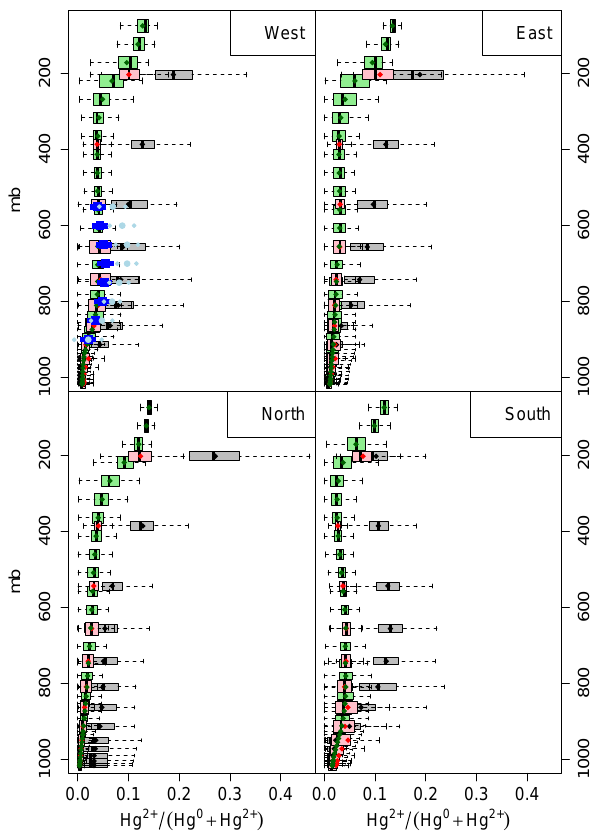
Fig. 3. April Hg 2 + /(Hg 0 + Hg 2 + ) GEOS Chem (gray), CMAQ Hemispheric (green), and adjusted GEOS Chem (pink) boundary conditions for the Hg regional 36km CONUS CMAQ domain. Uni- versity of Washington observations taken aloft using KCl denuders (dark blue) and difference techniques (light blue) are plotted on the top left